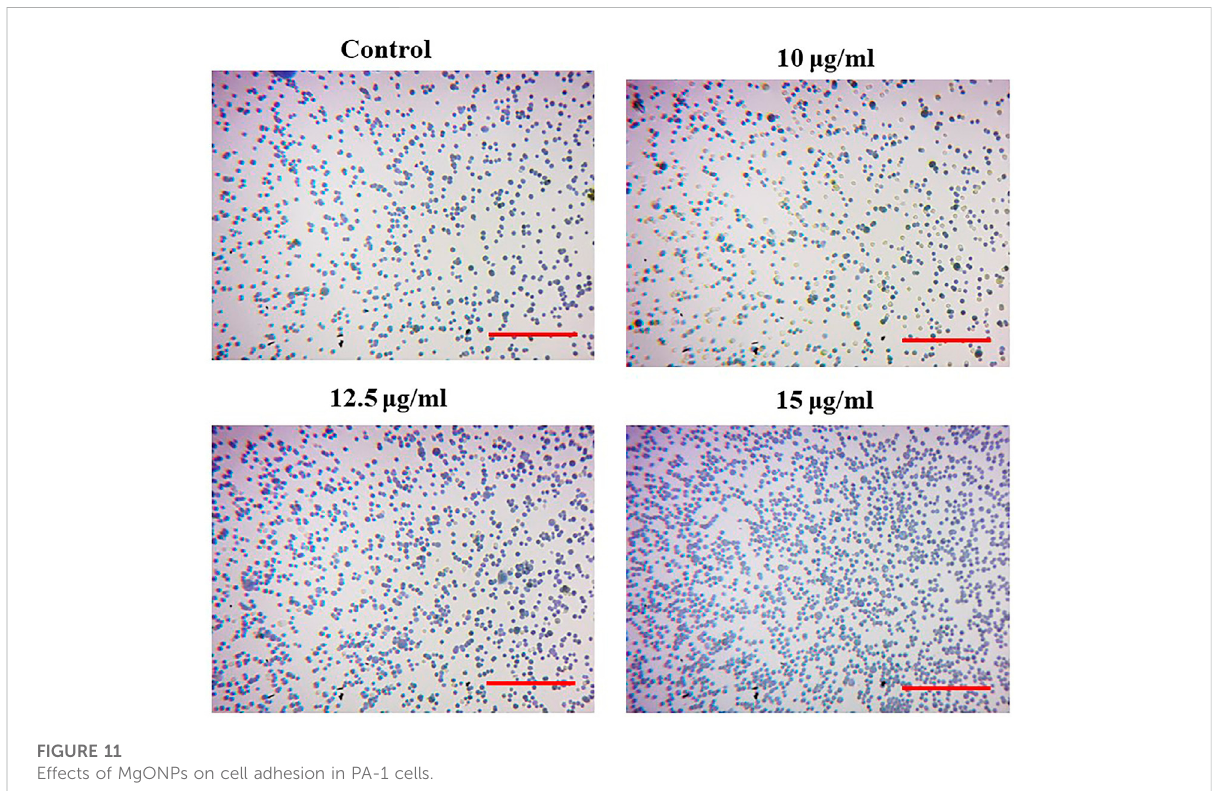
FIGURE 11 Effects of MgONPs on cell adhesion in PA-1 cells.